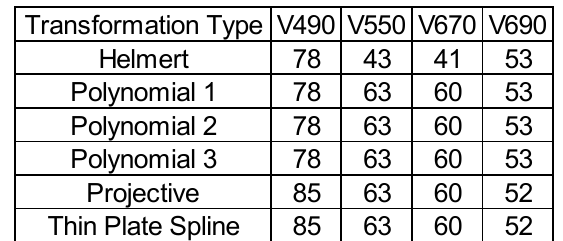
Table 1: Number of manually obtained ground control points (GCPs) used for each transformation type of Diwata-1 SMI data, with the guideline that the obtained residual value is below one-pixel unit. This was obtained by reprocessing the GCPs used for the TPS transformation to become usable by the lower order transformations.